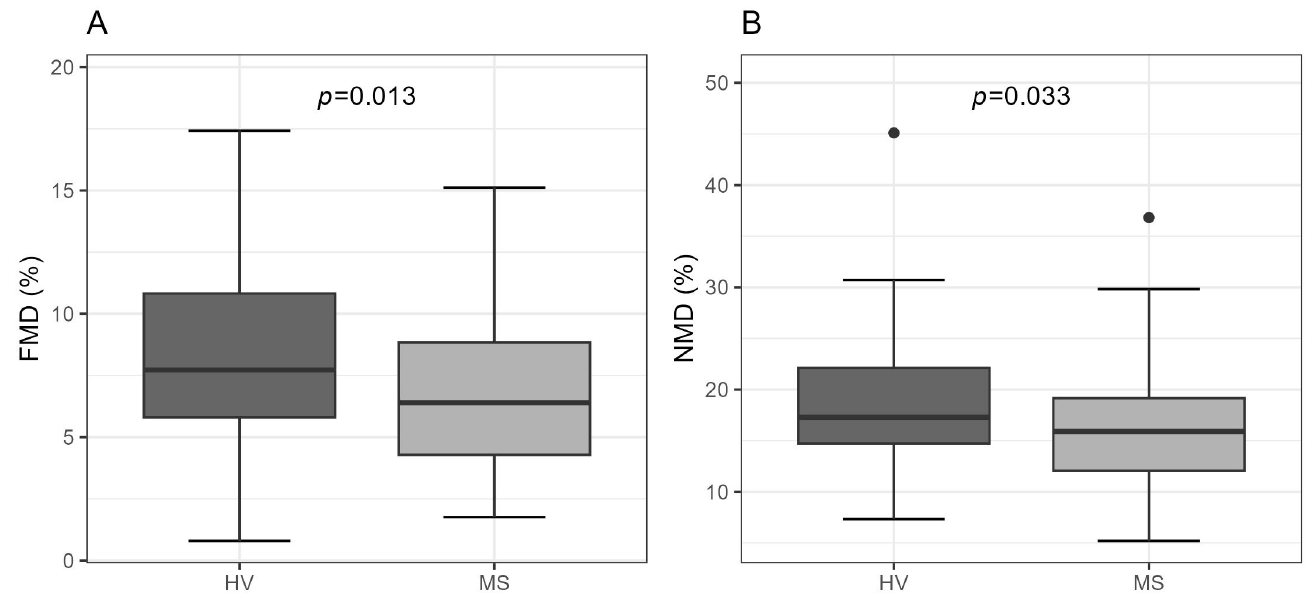
Figure 1. Boxplots of ( A ) FMD and ( B ) NMD in HV vs. MS patients. Data are presented as boxplots with median and range. Differences between the groups were tested with a t-test. HV, healthy volunteer; FMD, flow-mediated dilation; MS, metabolic syndrome patient; NMD, nitroglycerin- mediated